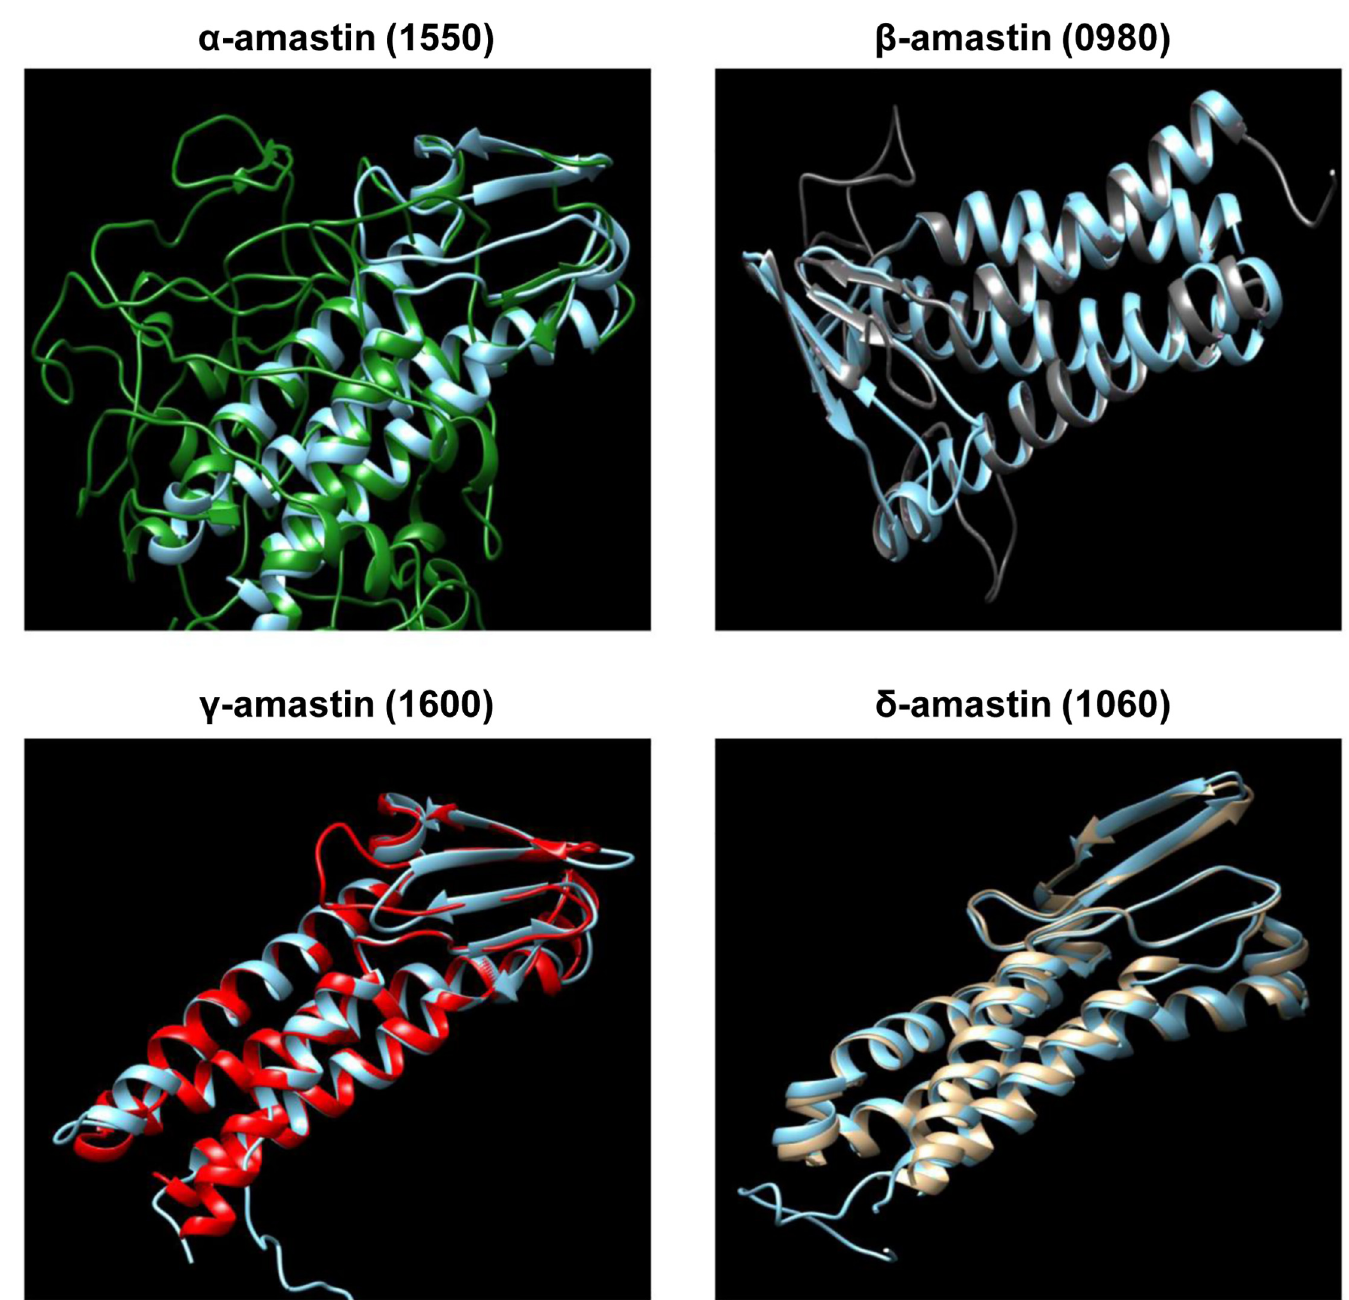
Fig 3. Homology-based 3D modeling of α , β , γ and δ amastins. Structural predictions were done using PHYRE web server and the predicted structures of α , β , γ and δ amastins, were imaged using the UCFS Chimera program. α -amastin is shown in green, β -amastin is shown in gray, γ -amastin is shown in red, δ -amastin is shown in yellow and the superimposed mouse claudin 15 model is shown in